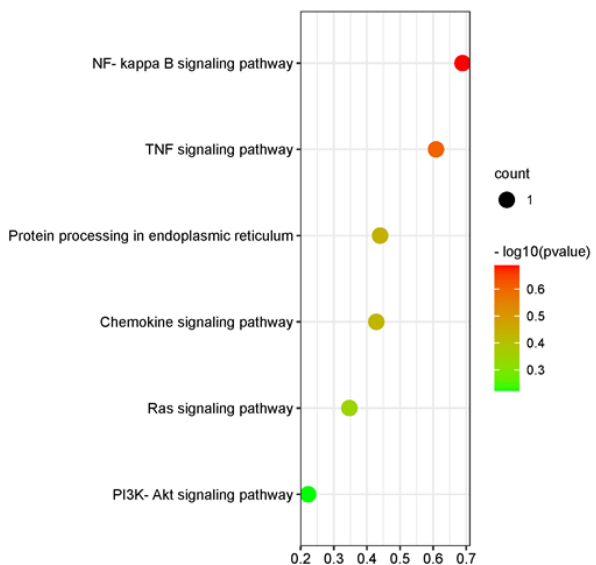
Figure 8. A significant difference in the target gene KEGG pathway of miRNA. The color of the dot represents the magnitude of significance in Figure 8.